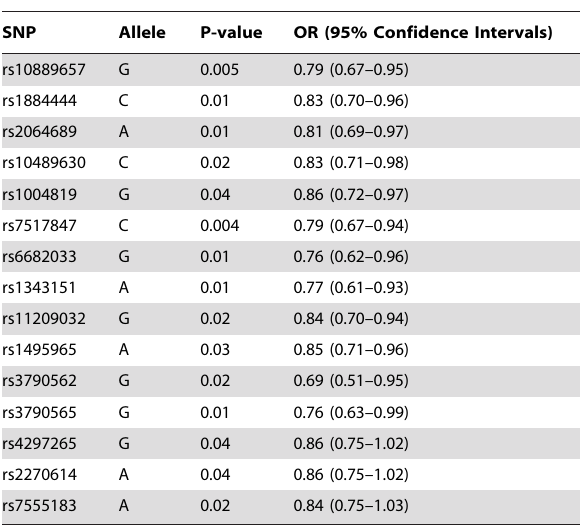
Table 2. List of significant (p , 0.05) SNPs in and around IL23R